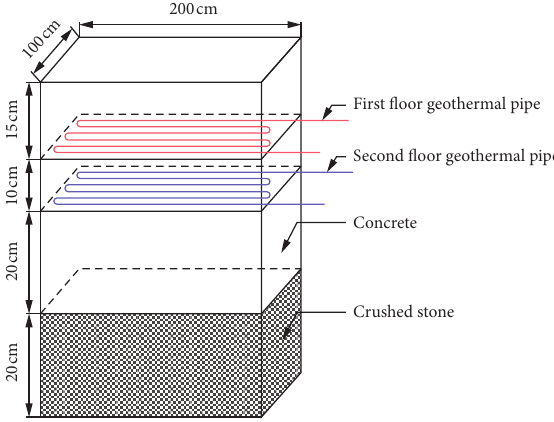
Figure 1: Concrete road model and buried depth design of geothermal pipes.